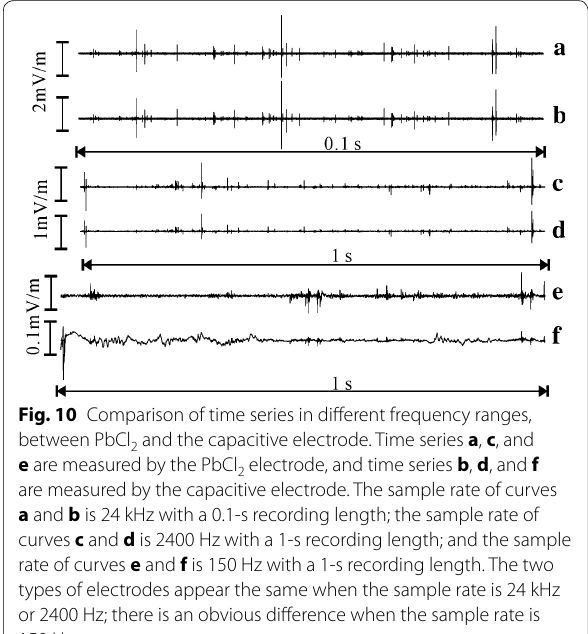
Fig. 10 Comparison of time series in different frequency ranges, between PbCl 2 and the capacitive electrode. Time series a , c , and e are measured by the PbCl 2 electrode, and time series b , d , and f are measured by the capacitive electrode. The sample rate of curves a and b is 24 kHz with a 0.1-s recording length; the sample rate of curves c and d is 2400 Hz with a 1-s recording length; and the sample rate of curves e and f is 150 Hz with a 1-s recording length. The two types of electrodes appear the same when the sample rate is 24 kHz or 2400 Hz; there is an obvious difference when the sample rate is 150